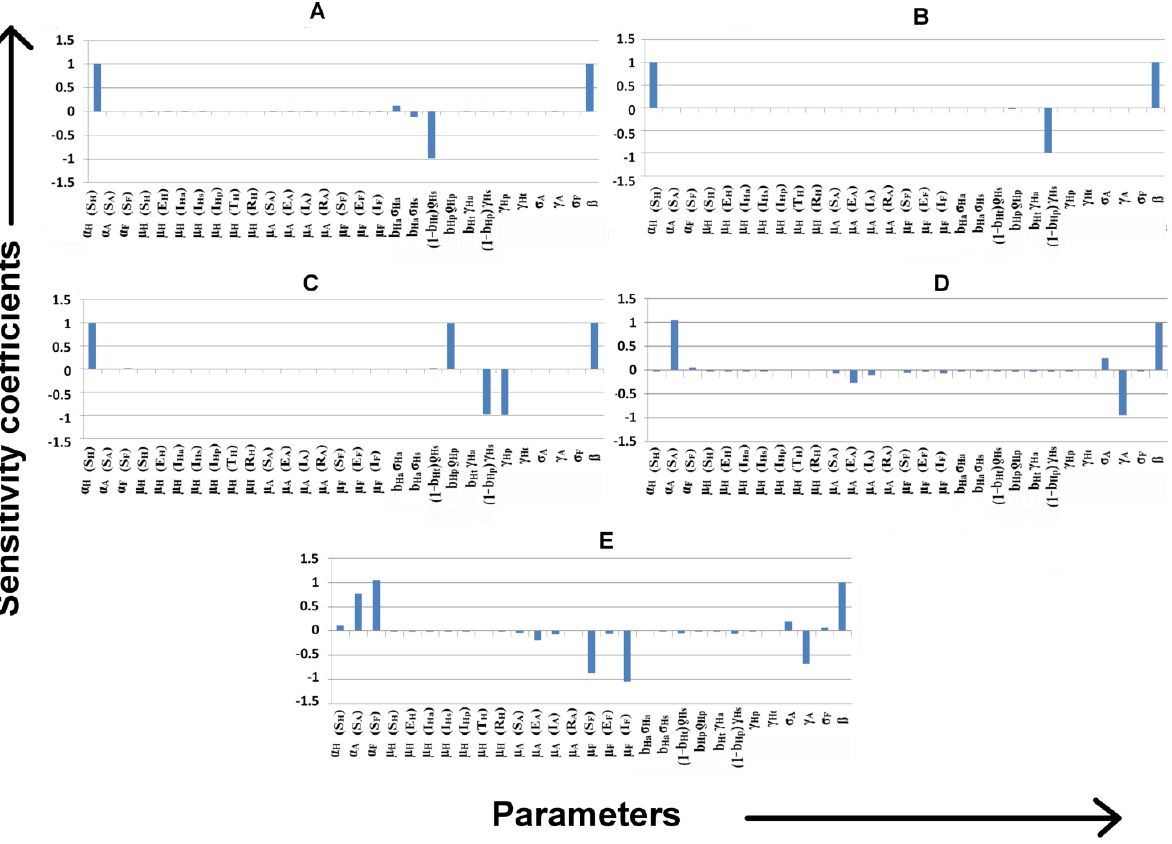
Figure 4. Local parameter sensitivity analysis for different model parameters and its effects on infected population groups. ( A ) Local parameter sensitivity for the variable I Ha ; ( B ) Local parameter sensitivity for the variable I Hs ; ( C ) Local parameter sensitivity for the variable I Hp ; ( D ) Local parameter sensitivity for the variable I A ; ( E ) Local parameter sensitivity for the variable I F . As some parameters are common for different events occurring in the model, the variable affected during the event has been indicated in brackets along with the